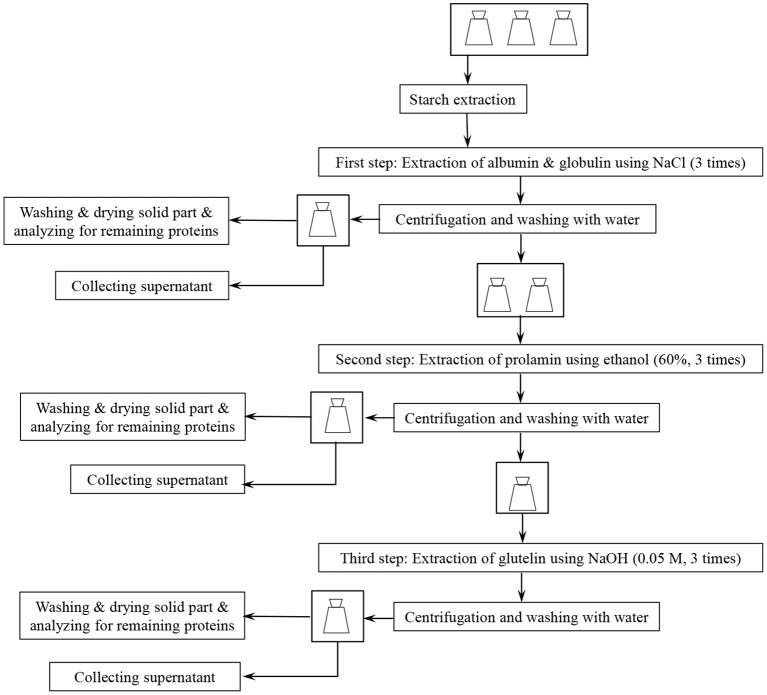
Flowchart for Osborne fractionation method for extraction of wheat bran proteins.